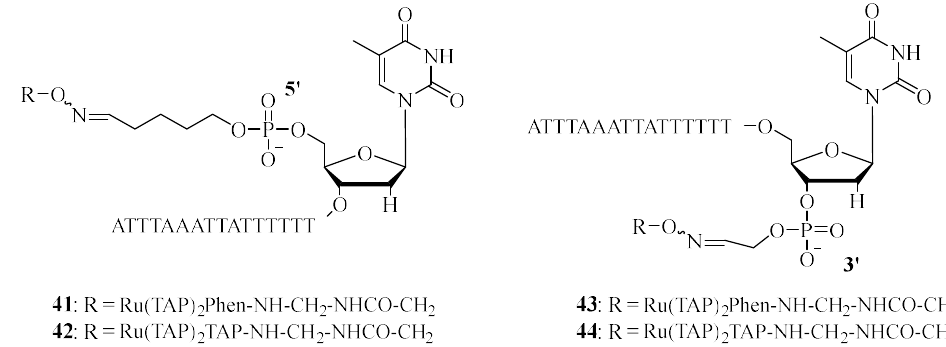
Figure 15. Structures of the oligonucleotide-Ru complexes 41 – 44 [132].